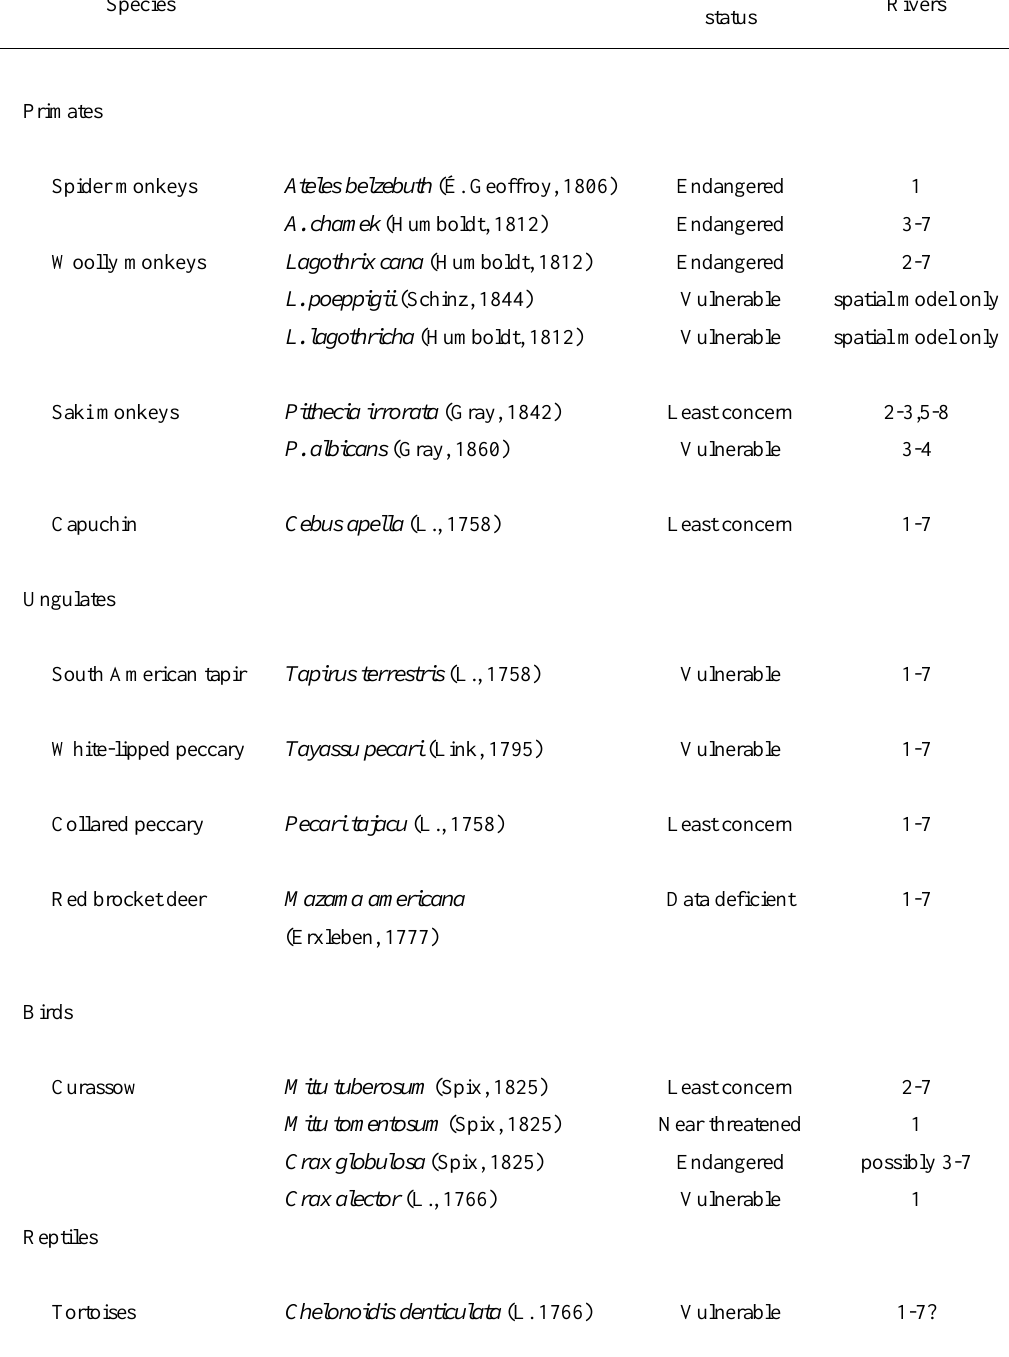
Table A1. Large vertebrate species for which the depletion zone (distance to nearest direct or indirect encounter within 12 months) was assessed using interviews with rural hunters in Amazonas State, Brazil. The known geographic range of the study species is indicated in relation to the rivers surveyed (taken from natureserve.org and iucnredlist.org). River numbers refer to those shown in a map of the study region (Fig.